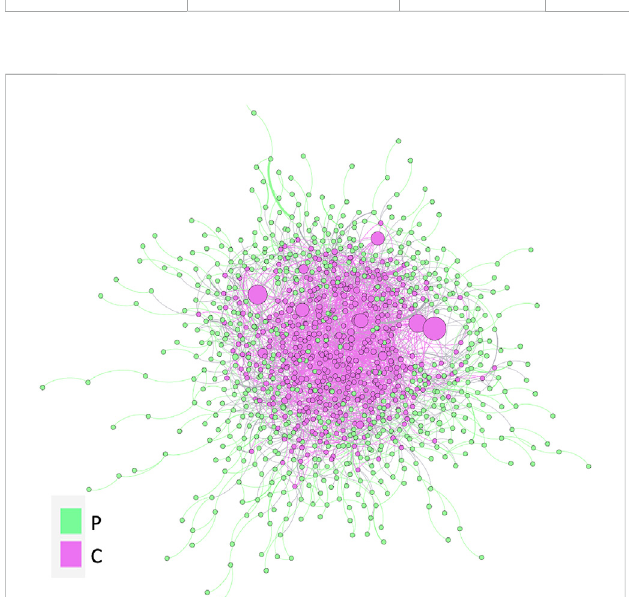
FIGURE 6 Board network in 2008 (tranquil period). A node represents a company, and an edge represents a link by interlocking directorates between boards. Node sizes denotethetotal assetsof acompany. Node colors indicate the core – periphery